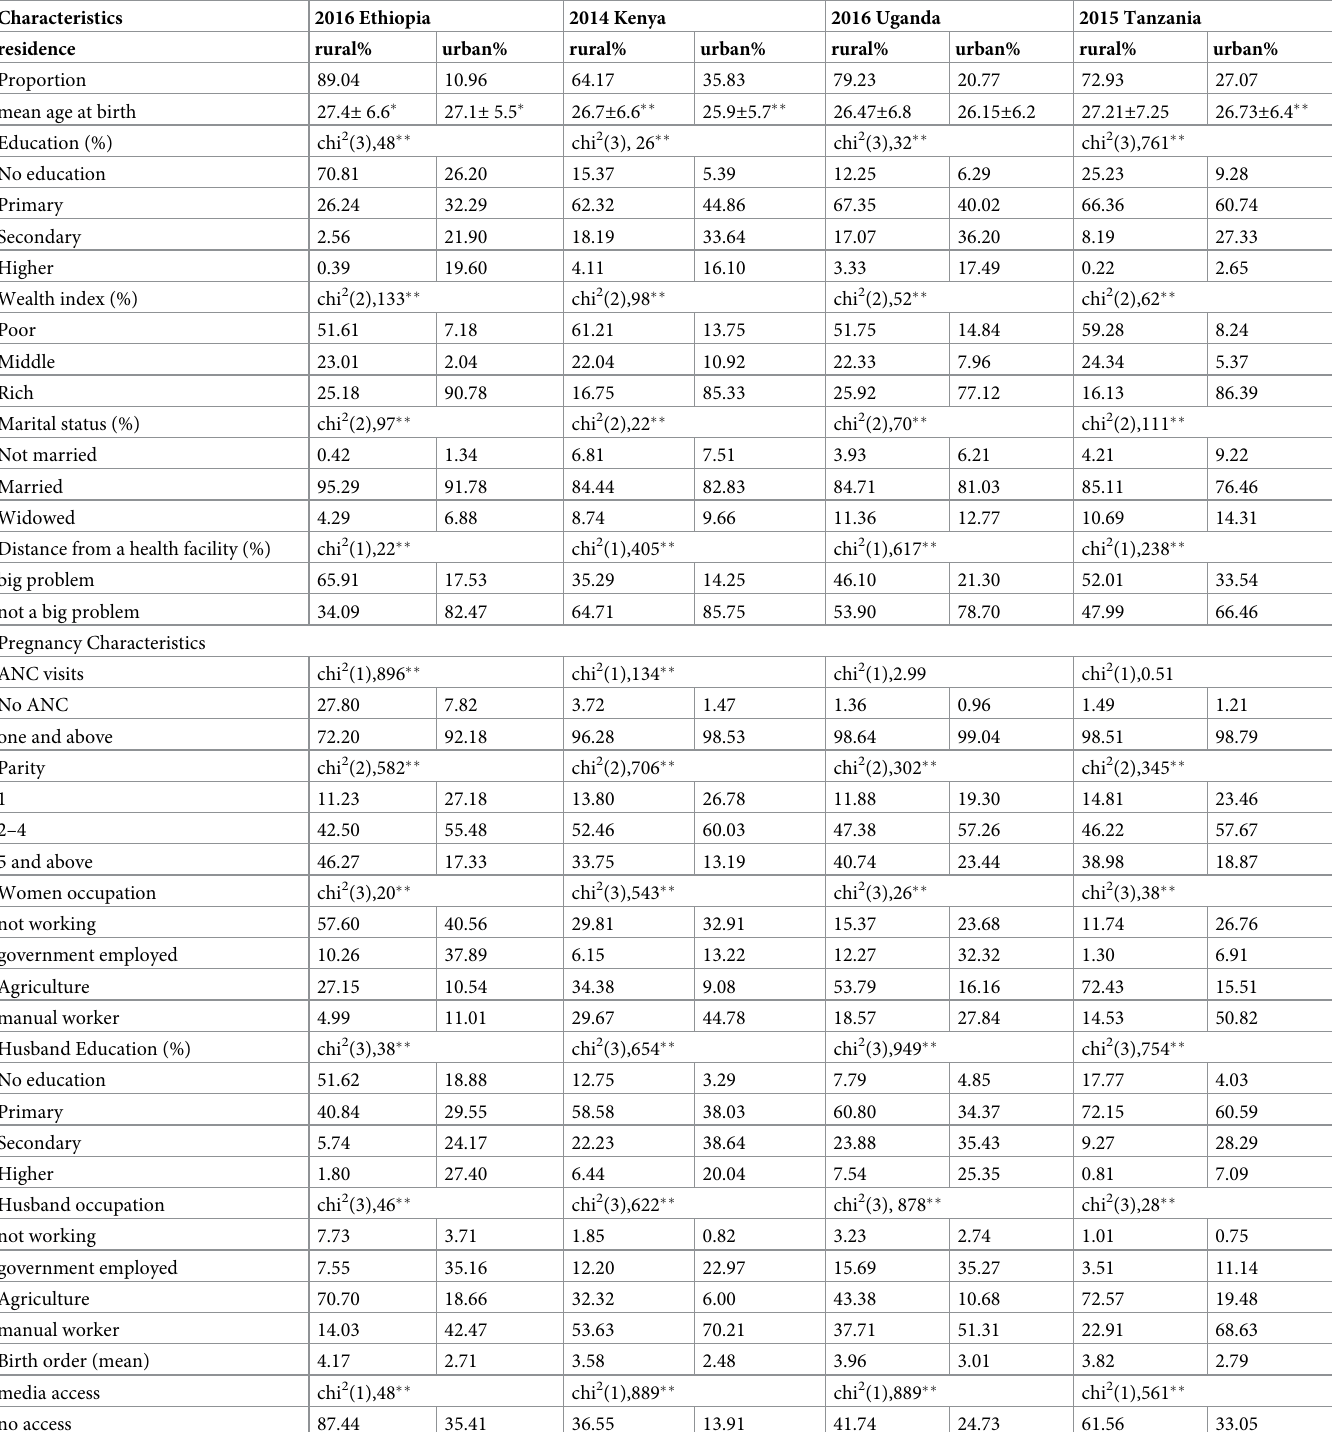
Table 1. Baseline characteristics of reproductive-age women by place of delivery in selected East Africa countries, 2014–2016.